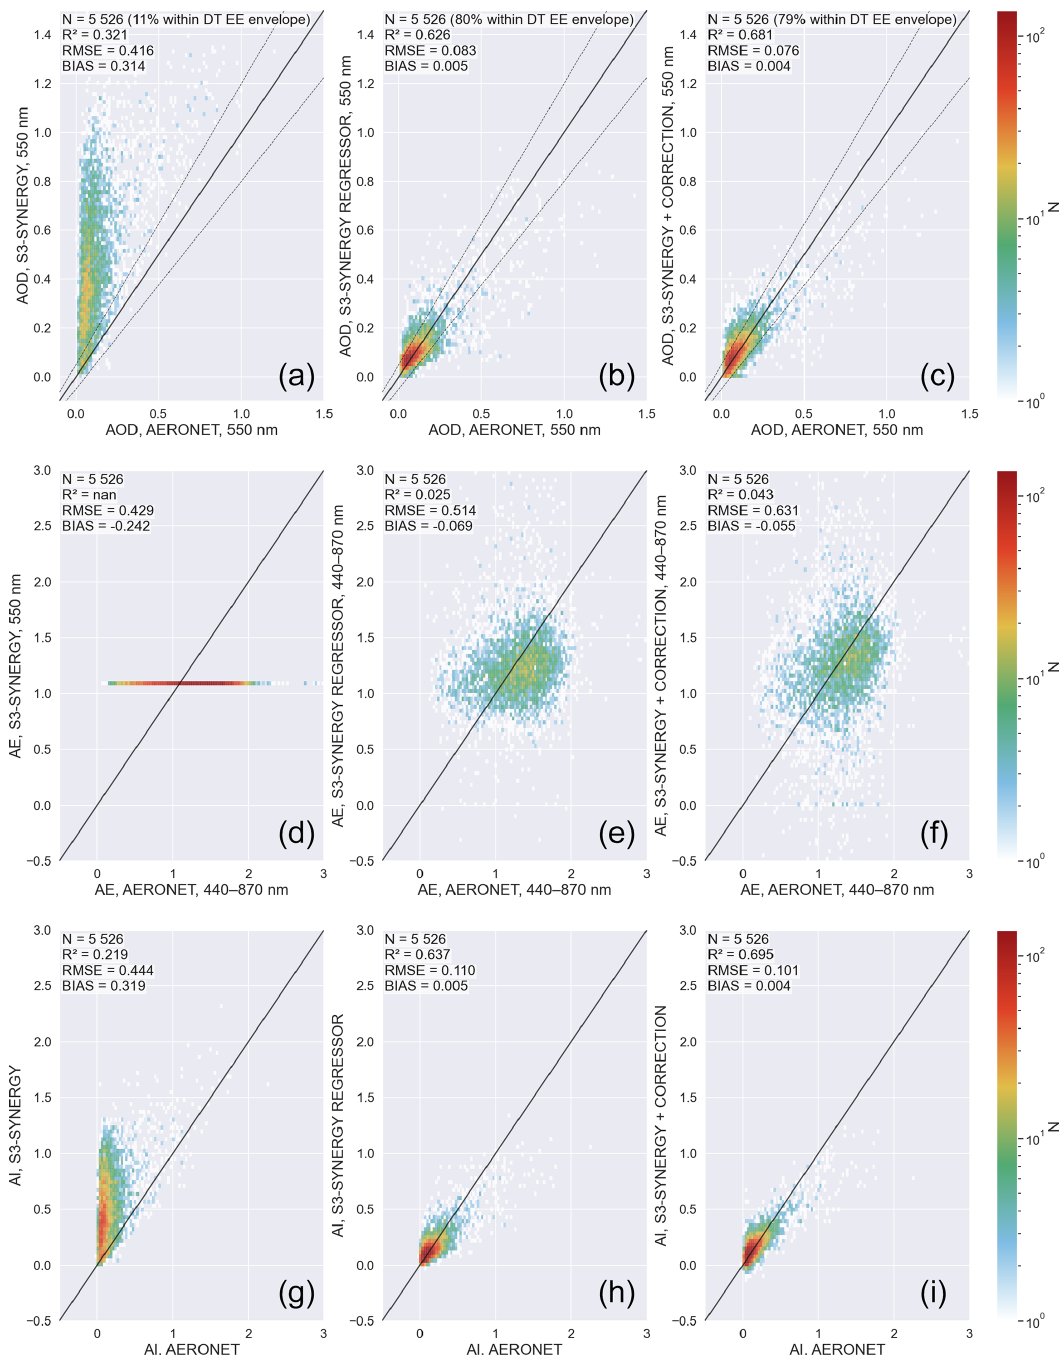
Figure 5. Rows from top to bottom: AOD (550nm), AE, and AI. (a, d, g) Sentinel-3 Level-2 Synergy product. (b, e, h) Fully learned regressor model. (c, f, i) Post-process correction